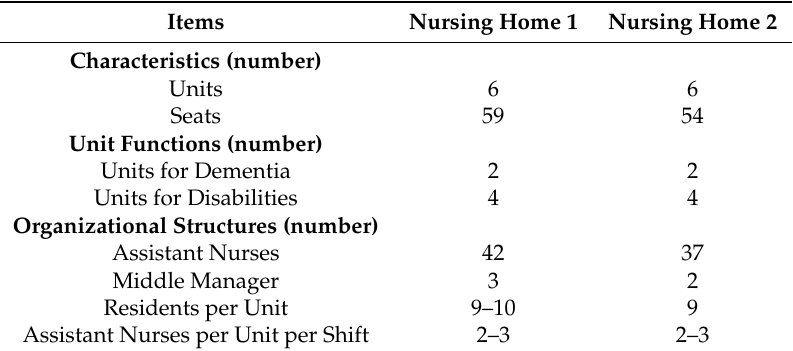
Table 1. Characteristics of selected nursing homes.